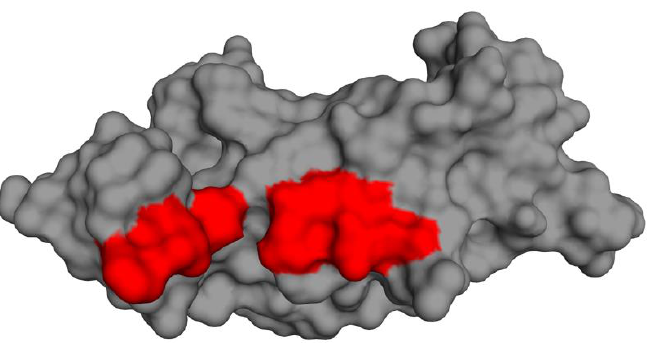
Figure 10. Surface view of the protein ’ s tertiary structure (gray) with the active binding site marked in red.